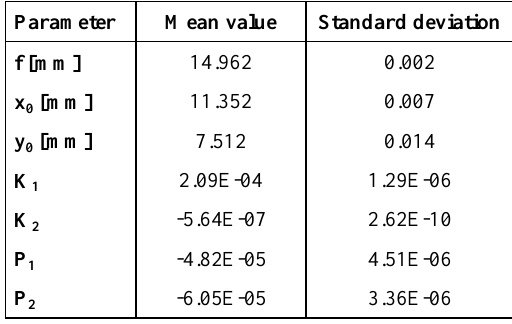
Table 2. The results of Sony NEX 5T calibration (Image Master)